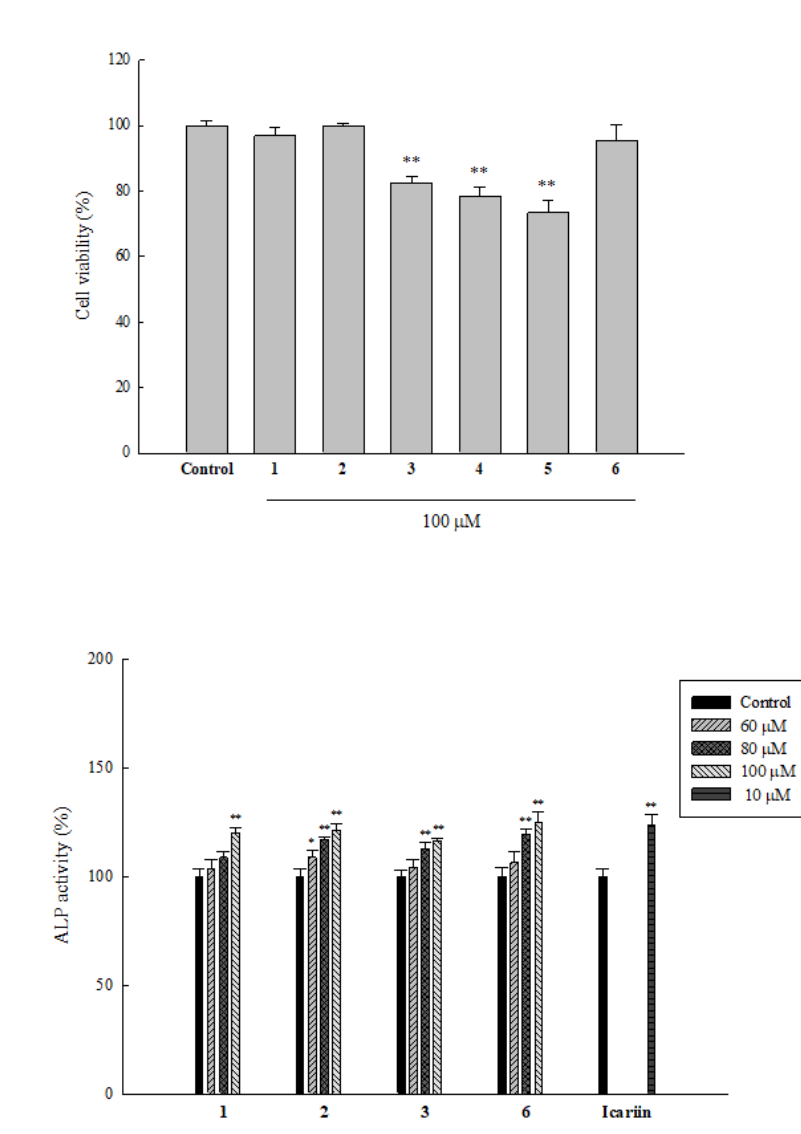
Figure 2. Cytotoxicity and induction ALP activity by isolated compounds in HOb cells. Cells were seeded in a 96-well plate, and after 24 h, 100 µM samples were added. ( A ) After five days, an MTT assay was performed to analyze cell viability. ( B ) After three days, ALP activity was detected by performing an ALP assay using bicinchoninic acid (BCA) protein to normalize protein expression of cells. Data are expressed as the mean ± SD, * p ≤ 0.05, ** p ≤ 0.01 compared to the control, and all experiments were performed in triplicate.